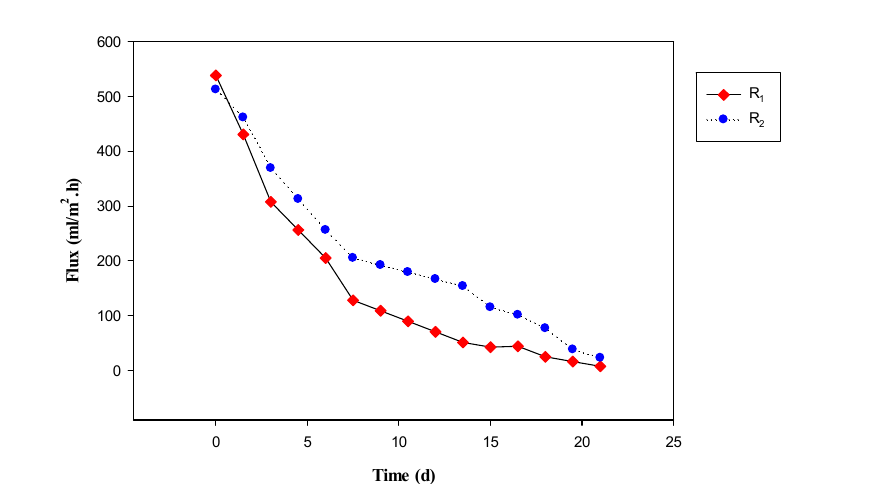
Fig. 7. Flux variation during the MBR operation